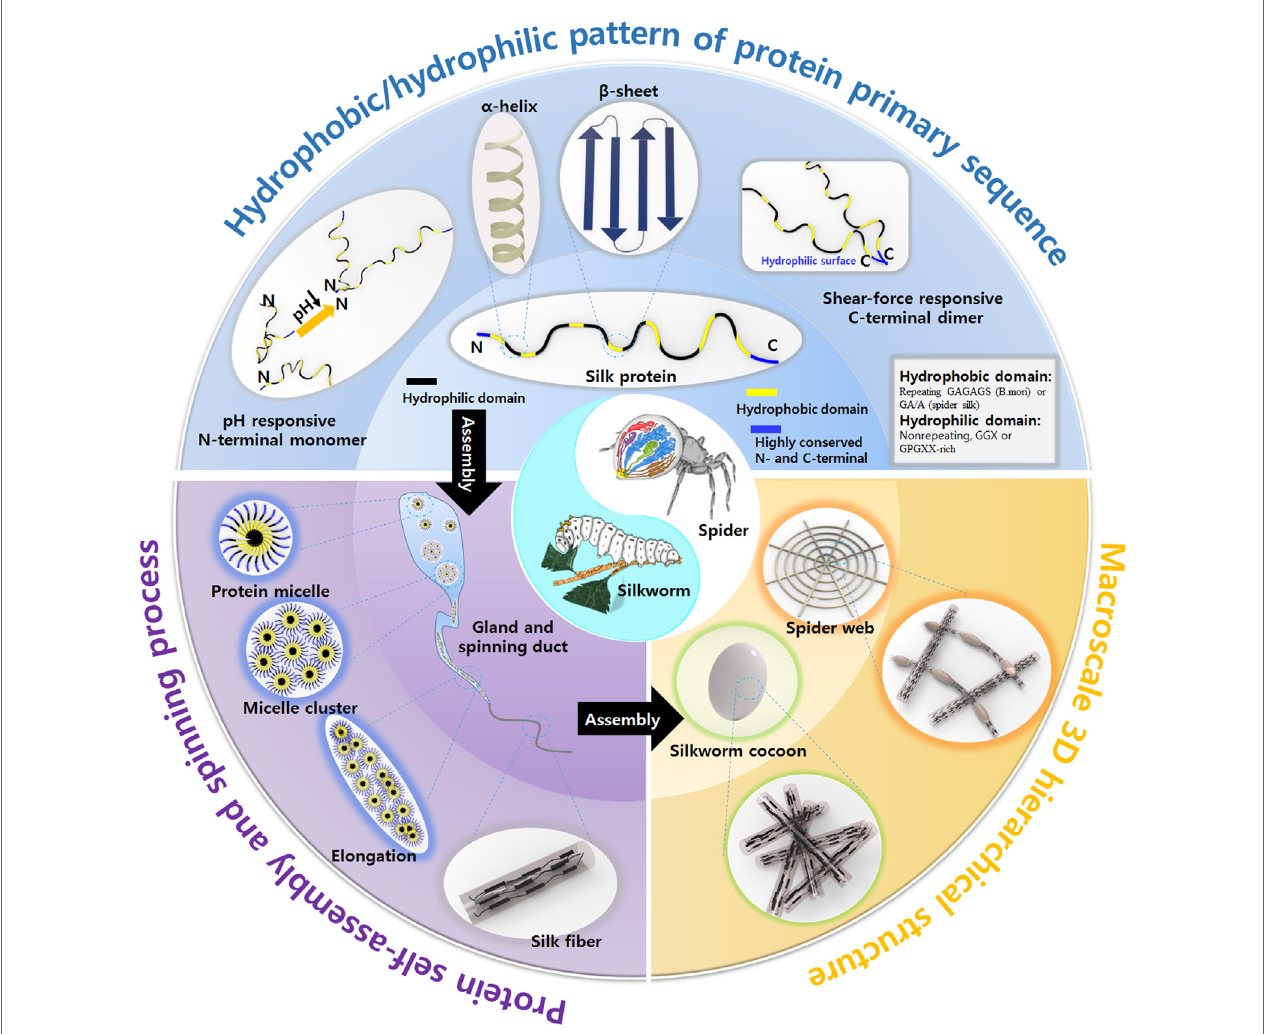
FiGURe 1 | Overview the inherent properties of natural silks produced by silkworm and spider, including the structural motif pattern of protein primary sequence, unique spinning process, and macroscale 3D hierarchical structure. Spider image: reprinted with permission from Kang et al. (2011). Copyright 2011 Nature Publishing Group; Silkworm image: reprinted with permission from Chae et al. (2013). Copyright 2013 John Wiley and